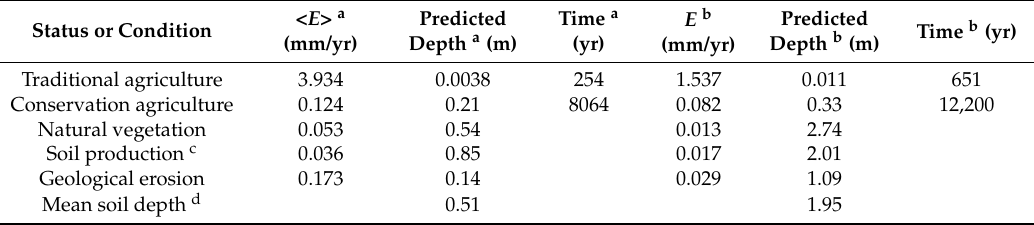
Table 2. Predicted steady-state soil depths for conditions reported by Montgomery